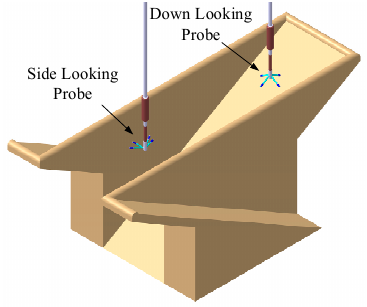
Figure 3. Velocity measurements near the vertical walls and sloped floors (upstream view, base model (weir height ( P ) = 325 mm)).